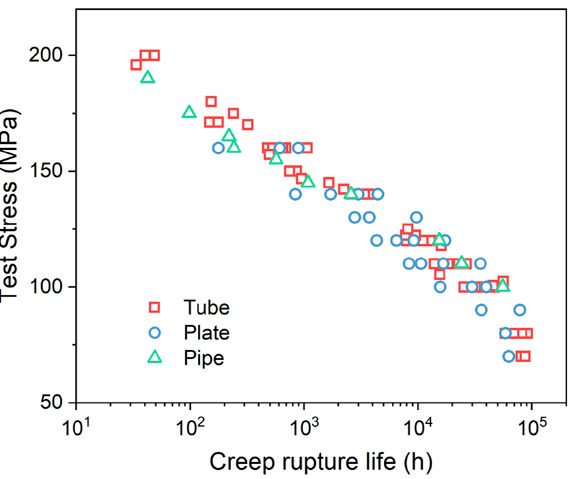
Figure 2. Instance of creep life distribution of modified 9Cr-1Mo steel with different forms at 600 °C.